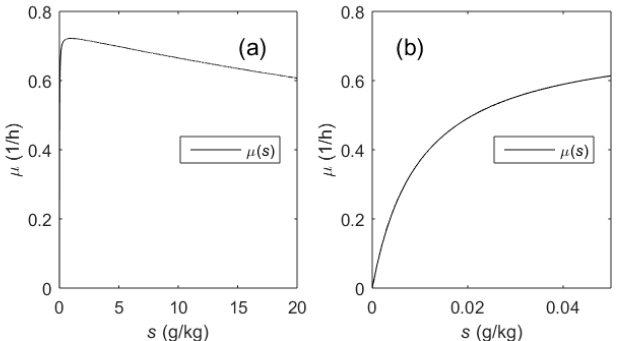
Figure 4. μ ( s ) kinetics (Equation (5)): Possible range of s concentrations in the cultivation medium ( a ), effective range of s concentrations ( b ) during μ control by means of substrate limitation.